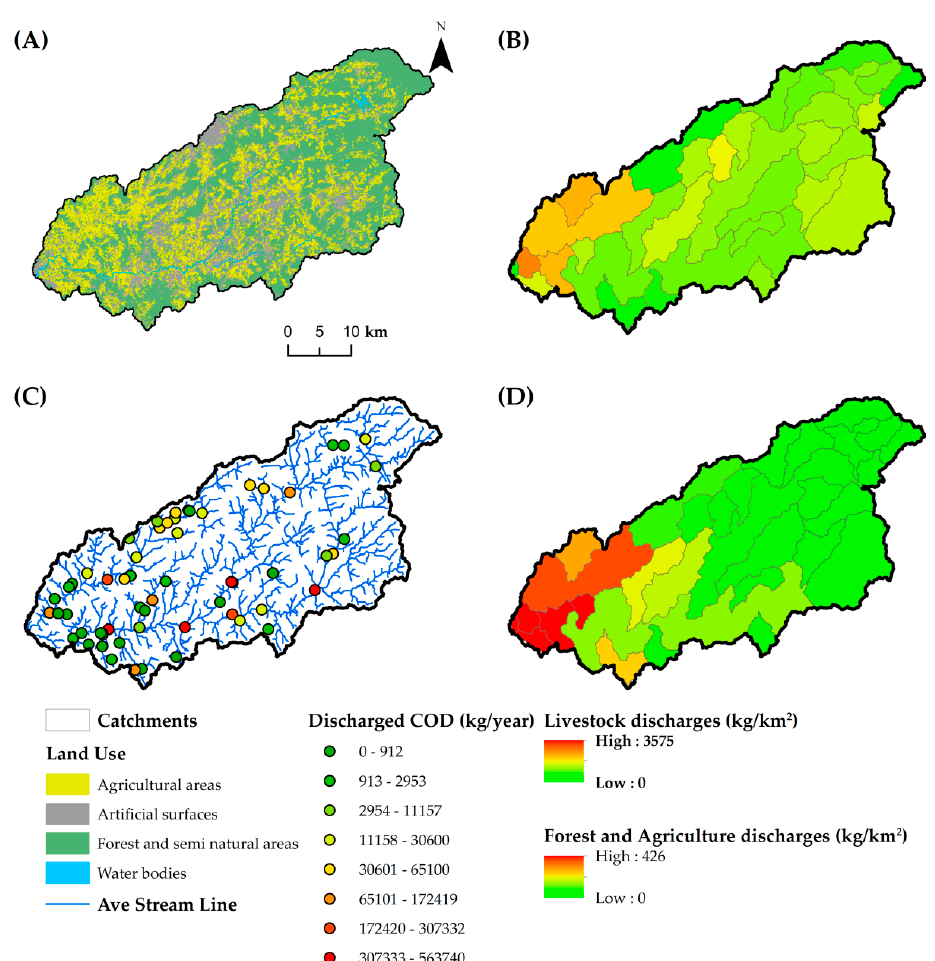
Figure 3. Spatial distribution of pressure data used in the partial least-squares path models (PLS-PMs). ( A ) Land Uses. ( B ) Forest and agriculture discharges of nitrogen. ( C ) Effluent discharge locations. ( D ) Livestock discharges of nitrogen.